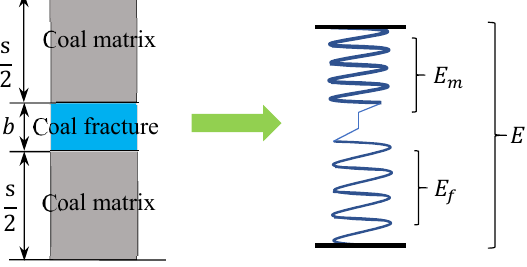
Figure 3. Illustration of the series methane flow in the dual-pore coal.